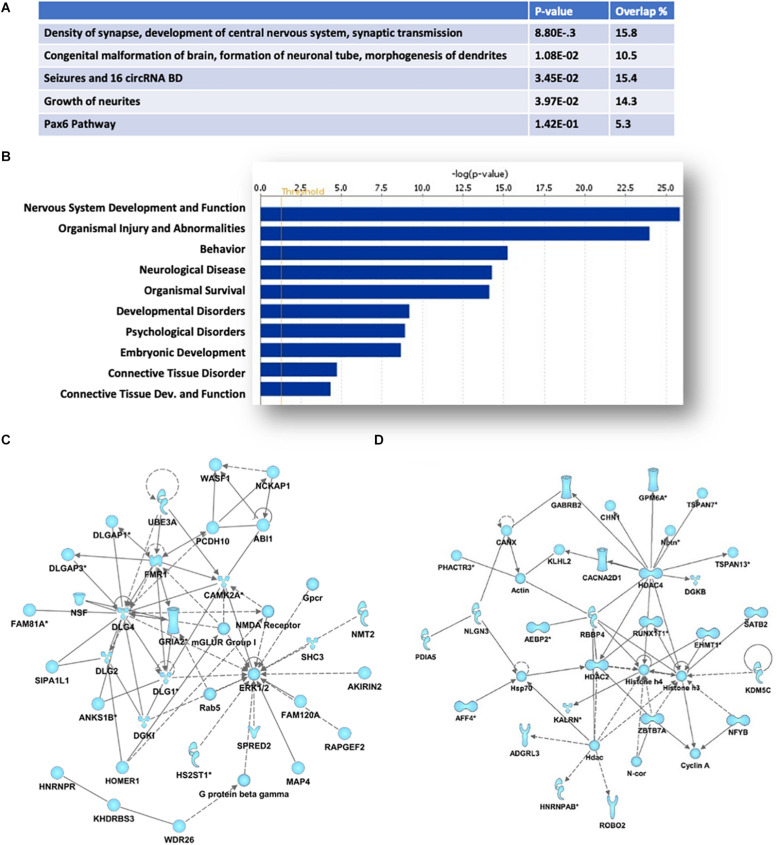
Pathway and functional analyses of host genes of HuD target circRNAs. Ingenuity Pathway Analysis of HuD interacting circRNAs identified by RIP. (A) Top molecular functions associated with genes associated with HuD-bound circRNAs. (B) Top Diseases and Functions. (C,D) Representative networks including circRNAs from genes encoding proteins involved in glutamatergic transmission (C) and epigenetic regulators (D).